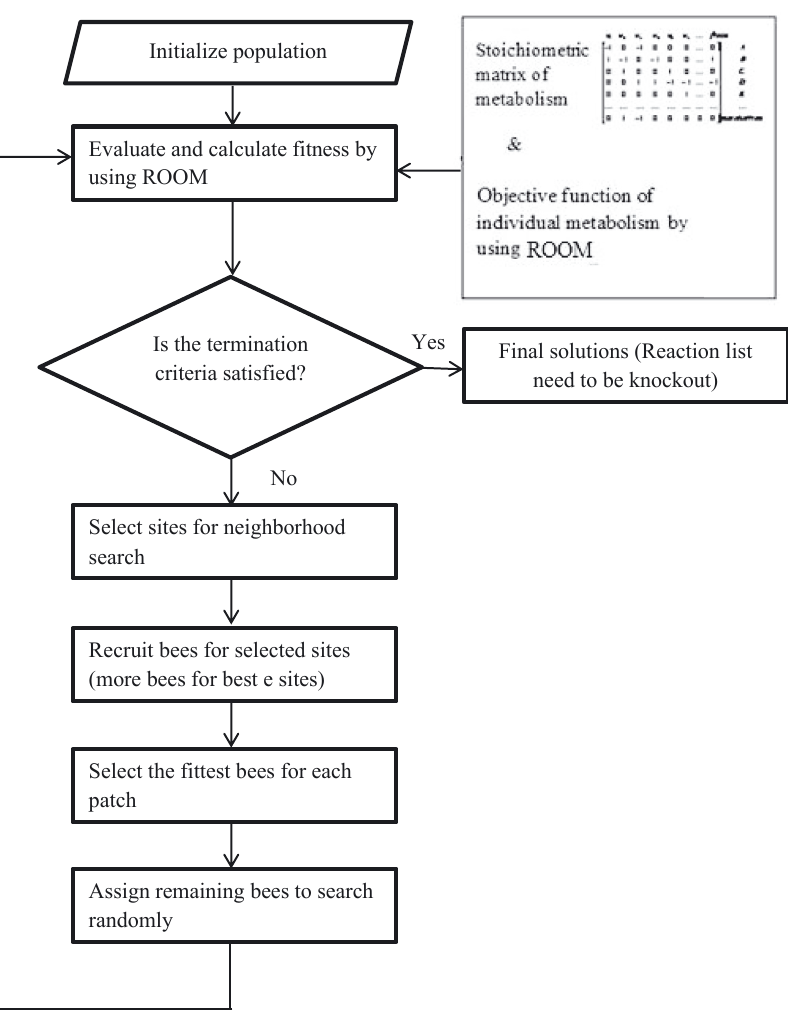
Figure 3: The flow chart of hybrid algorithm of